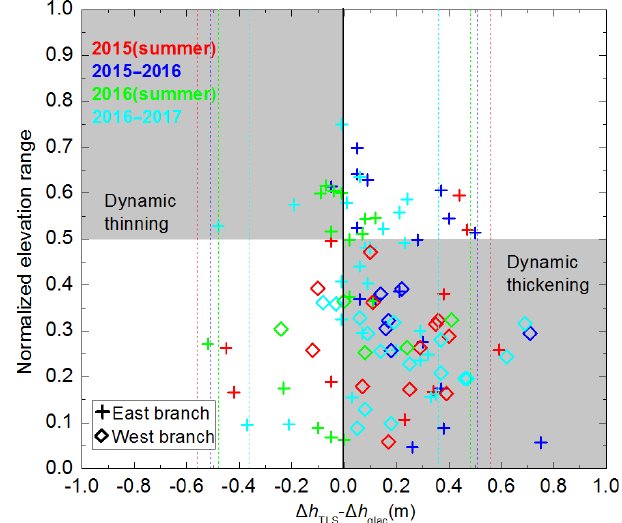
Figure 9. Changing differences between TLS-derived ( (cid:49)h TLS ) and glaciological ( (cid:49)h glac ) annual and summer surface elevation changes at individual stakes versus normalized glacier elevation range of the east branch and west branch for the four investi- gated periods. Note that dashed vertical lines indicate the uncer- r (cid:16) (cid:17) 2 2 ) of the changing dif- + + (σ firn σ 2 σ ice a tainty ranges ( a ) (cid:49)h TLS ferences ( (cid:49)h TLS − (cid:49)h glac ), and grey quadrants indicate theoretical areas for Urumqi Glacier No. 1 in